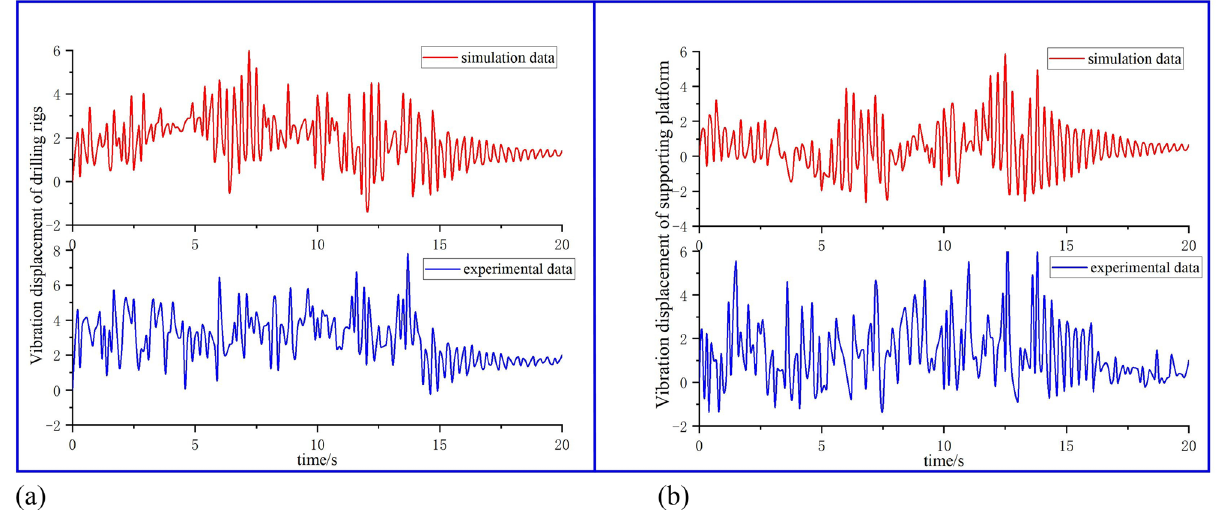
Figure 15. Vibration simulation and test comparison diagram of key components of anchoring system: ( a ) comparison diagram of vibration response theory and test of drilling rigs; ( b ) comparison diagram of vibration response theory and test of supported